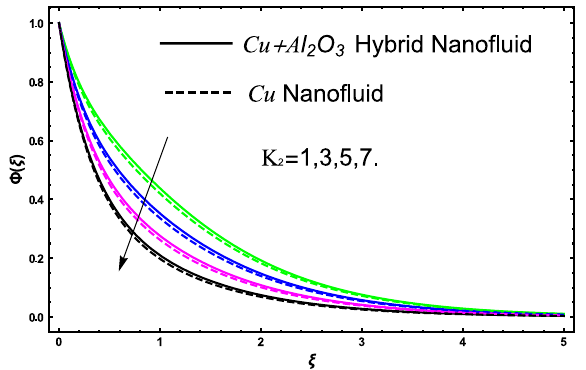
Figure 13. The fluctuation of concertation φ(ξ) versus escalating values of K 2